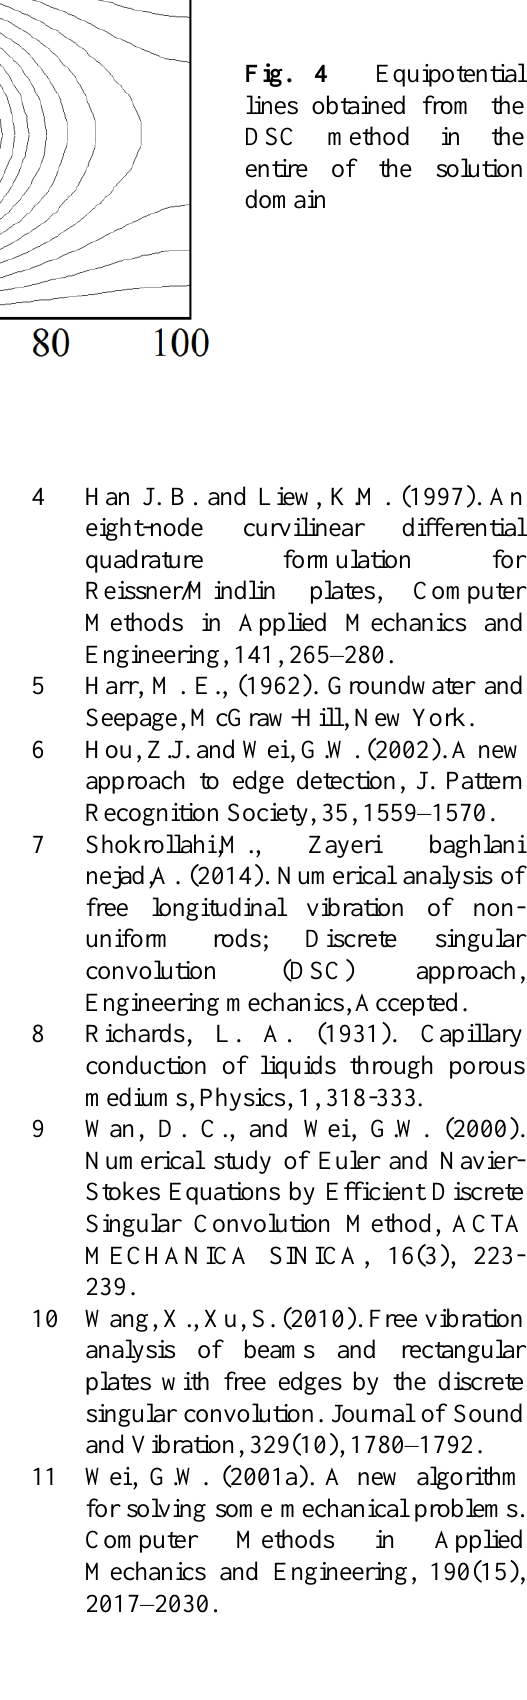
Fig. 4 Equipotential lines obtained from the DSC method in the entire of the solution